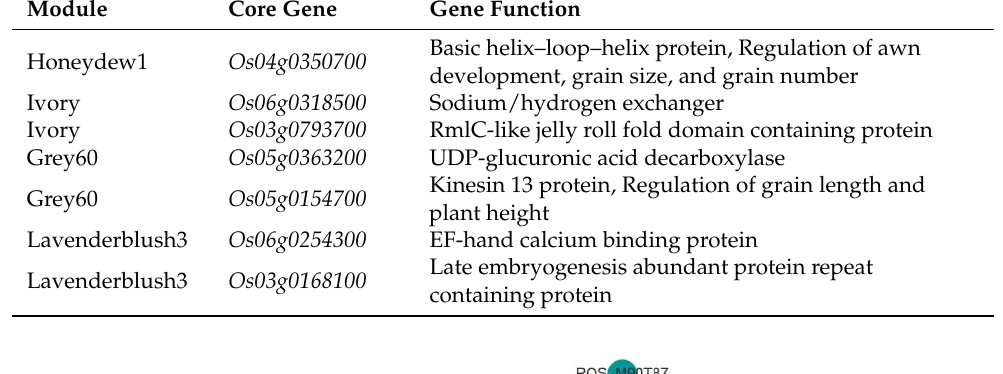
Table 3. Functional annotation of core genes in yield- and quality-related modules.